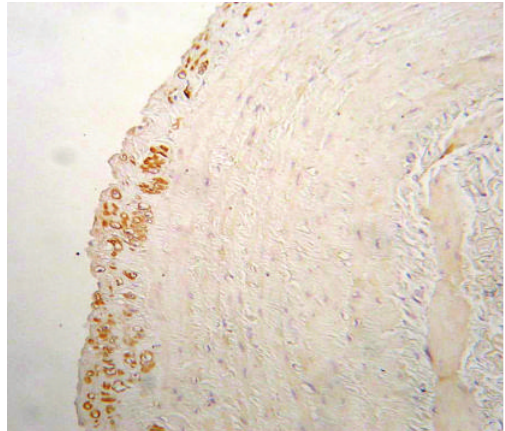
Figure 10: Enhanced nNOS positivity in tunica intima (compared with tunica media) of varicose vein of 32-yrear-old man (V55), magnification 200x,